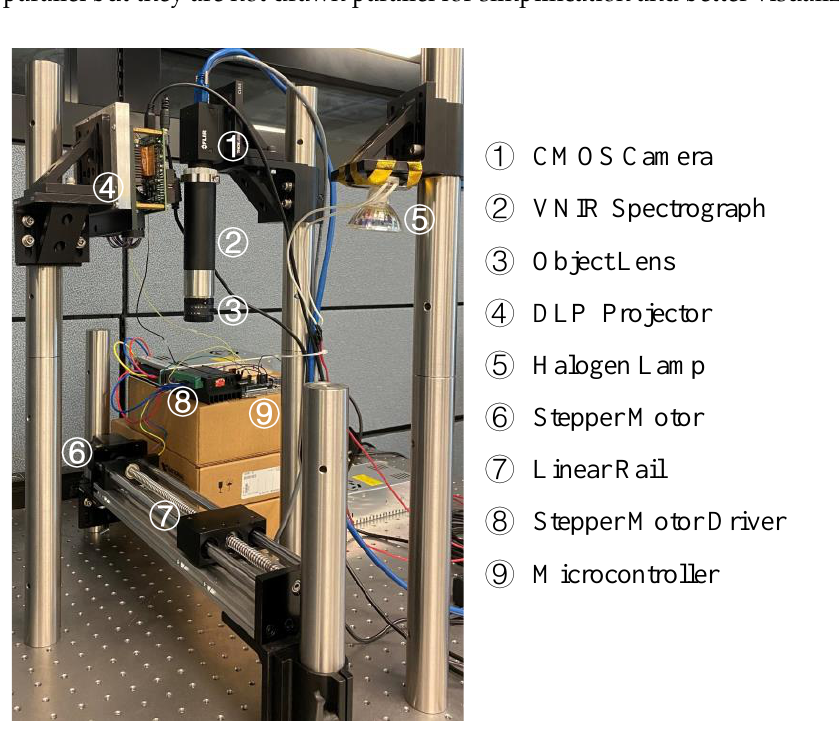
Figure 9. Physical setup of 4D line-scan hyperspectral imager (reprinted with permission from [55] © The Optical